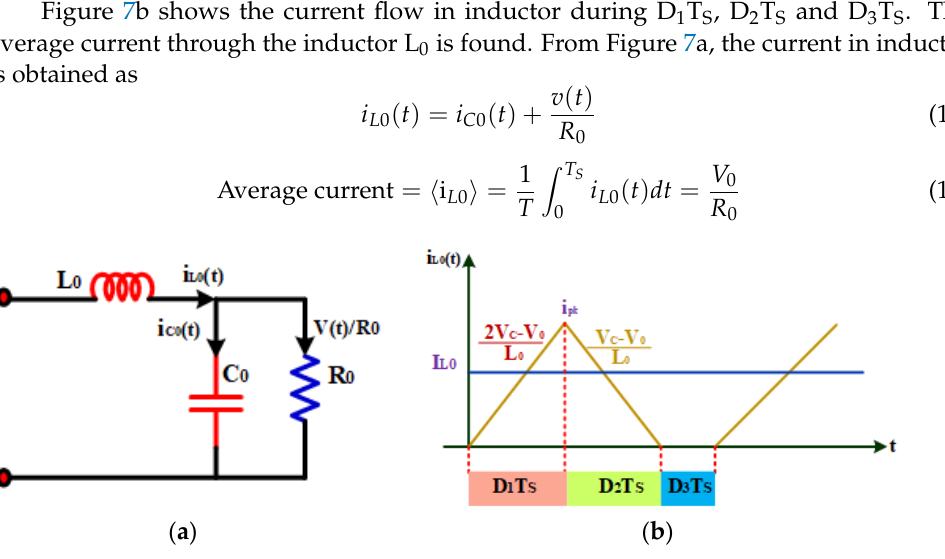
Figure 7. ( a ) Proposed Converter configuration in DCM; ( b ) Proposed converter DCM waveforms illustrated.